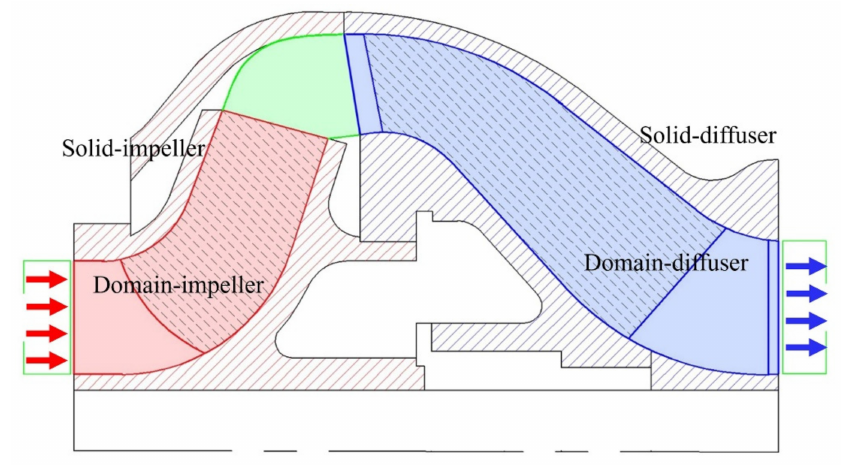
Figure 2. Axial section of impeller and